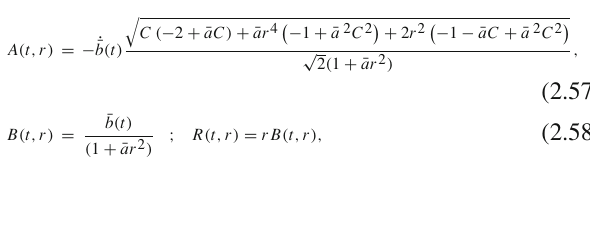
collapse reaches its end state at t = 0. b Plot of the mass m , Eq. (2.56) of the star with respect to t . It can be seen that the mass is linear function of time coordinate and the mass radiates throughout the